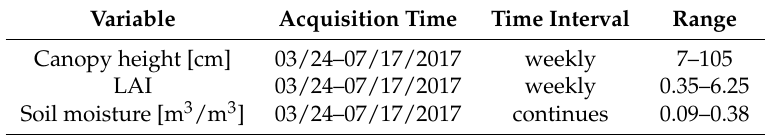
Table 1. Acquisition time, time interval, and range of dynamic in-situ measurements.